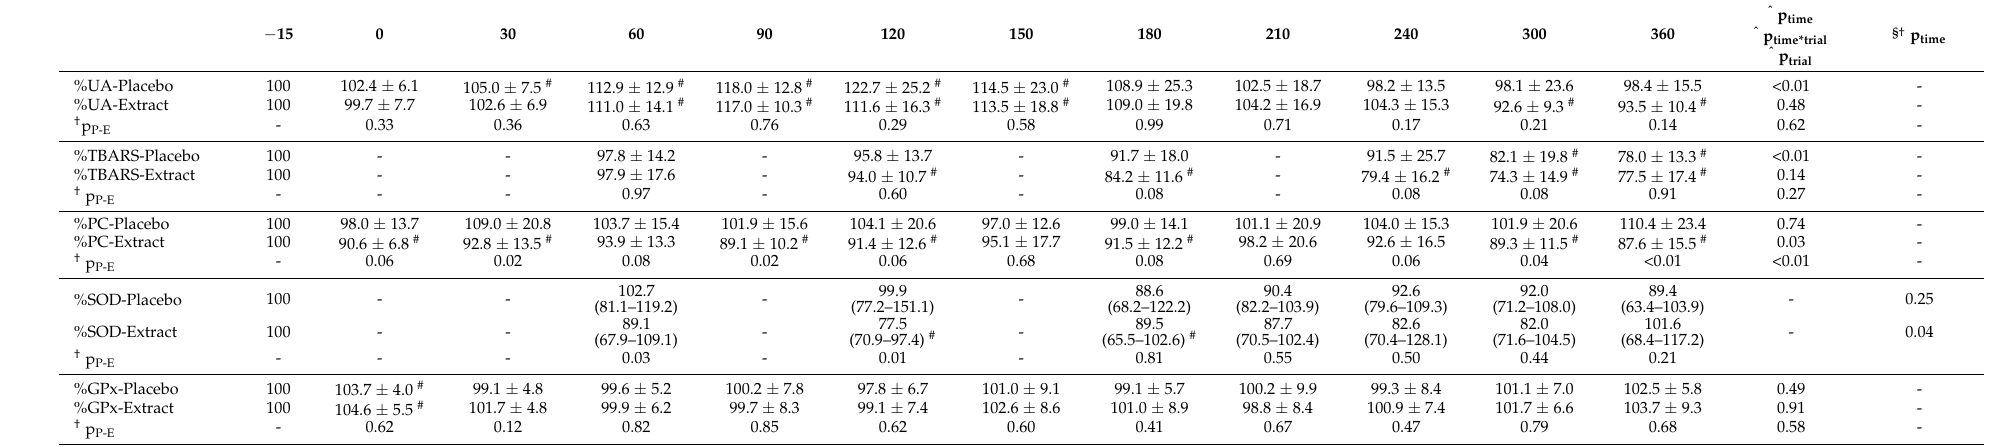
Table 5. Percentage of change in oxidative and endogenous antioxidant biomarkers in the two intervention